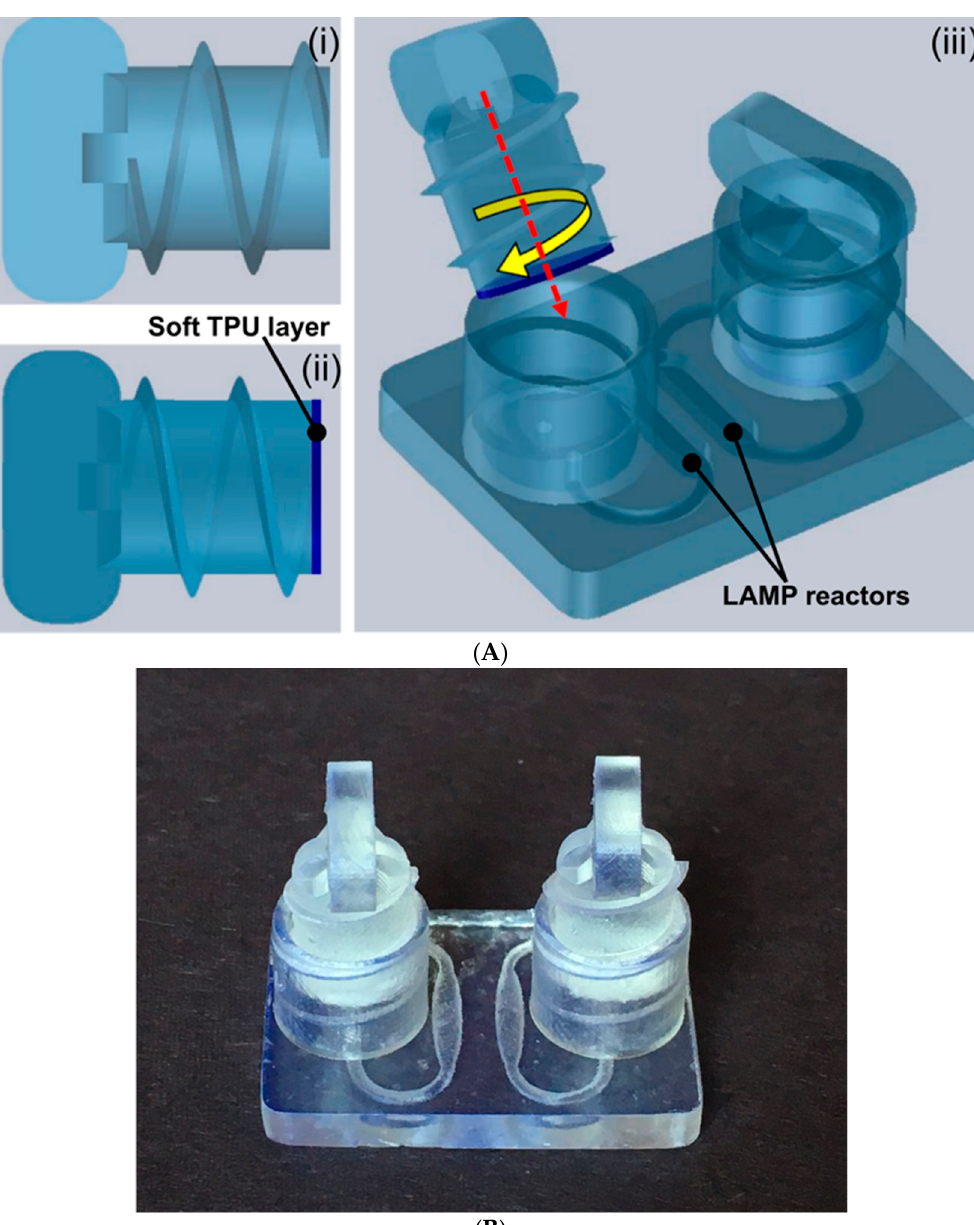
Figure 5. ( A ) Schematic illustration of the 3D-printed, hard–soft microfluidic LAMP chip platform for molecular detection. (i) Hard SLA-printed threaded screw sealer. (ii) Hard–soft threaded screw sealer with soft TPU material. (iii) Assembled hard–soft microfluidic LAMP chip platform. ( B ) Photo of the 3D-printed microfluidic LAMP chip platform with two hard–soft threaded screw sealers.